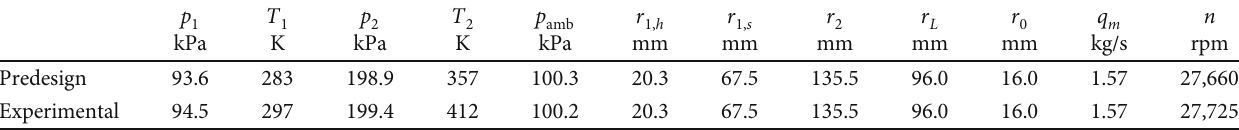
Table 10: Parameters of the centrifugal compressor used in the hybrid